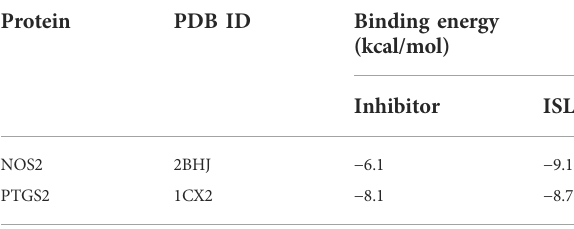
TABLE 1 The binding energies of ISL with NOS2 and PTGS2 protein